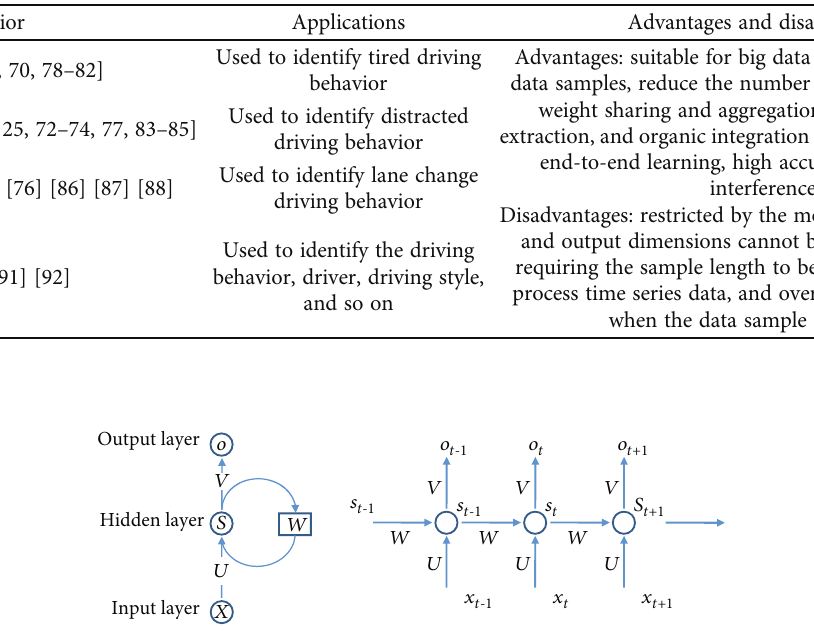
Table 4: The characteristic analysis of CNN.